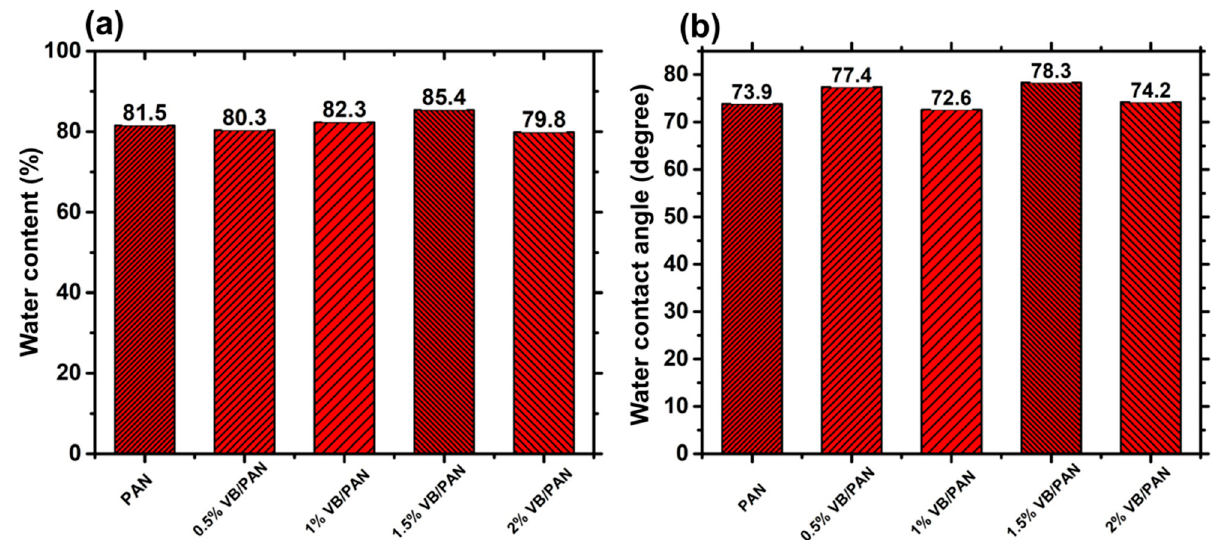
Figure 4. Hydrophilic behaviors of PAN and VB/PAN nanofibers ( a ) Water content and ( b ) Water contact angle.